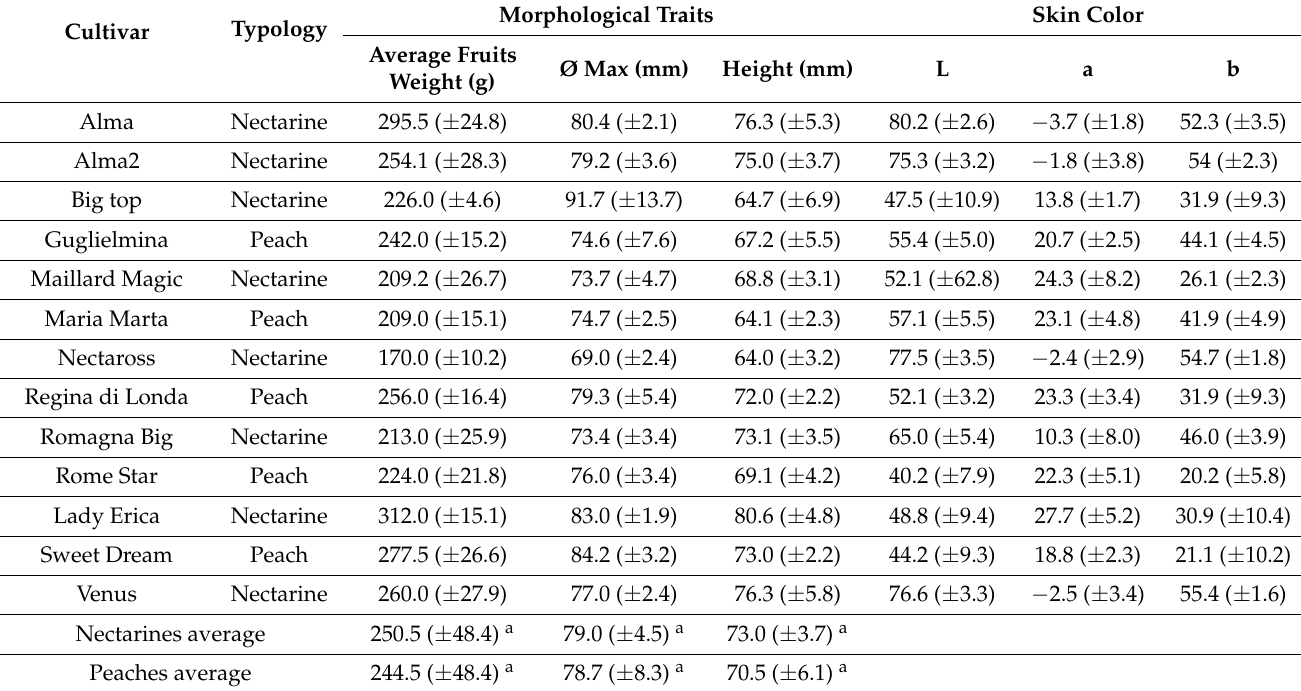
Table 1. Morphological parameters: morphological traits (fruit average, Ø and height) and skin color (L, a, b). For morphological traits, different letters in the same row (nectarine and peaches grand total) denote significant differences among samples means ( p < 0.05) (ANOVA).